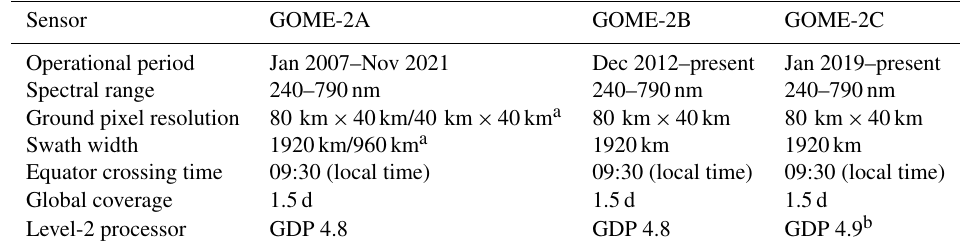
Table 1. Summary of the GOME-2 instrument